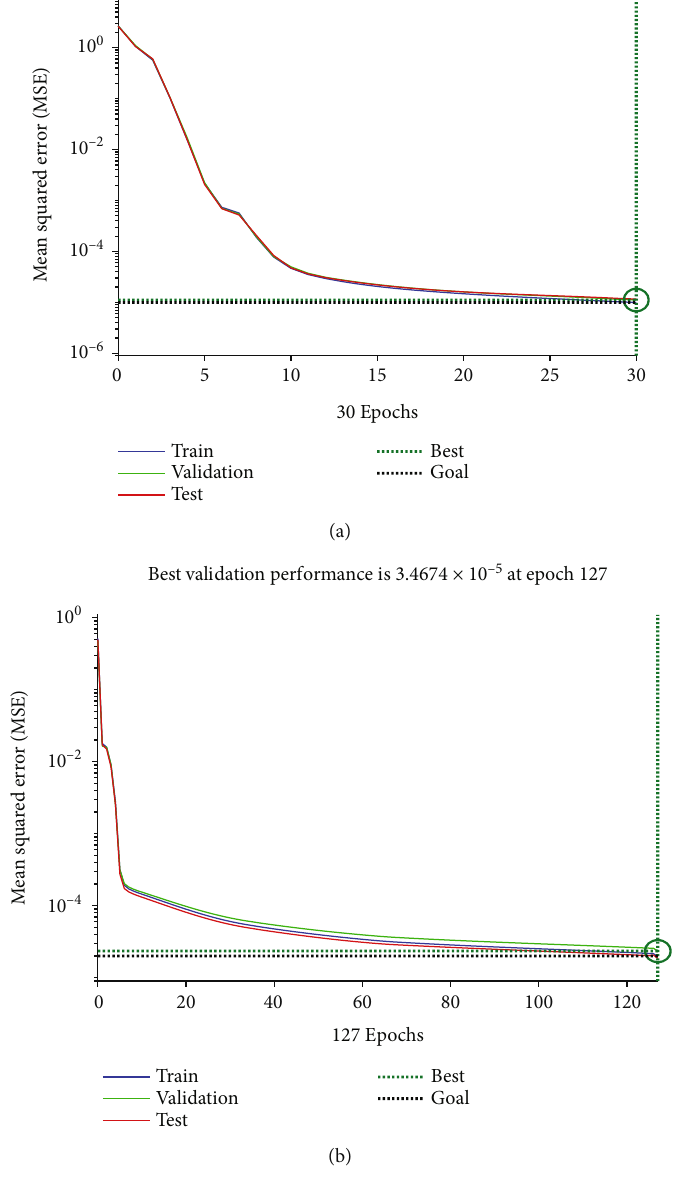
Figure 9: The best performance curves of (a) trained ElmanNN (b) conventional